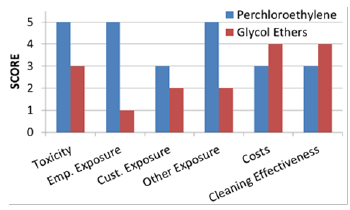
Figure 5. Overall comparison of PCE to GEs using the scoring algorithm described in detail in the text.